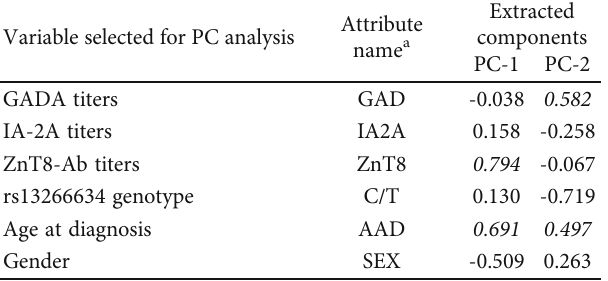
Table 4: Six clinical, immunological, and genetic T1D variables were included in PC analysis. The factor-loading matrix for two principal components illustrates the stronger or weaker in fl uence of each variable on each component. Variables displaying an absolute factor loading ≥ 0 : 4 (in italic) were considered representative of each PC. A positive sign in the factor indicates that the PC was in fl uenced by higher values of the original variable, while a negative sign indicates the in fl uence of lower values.